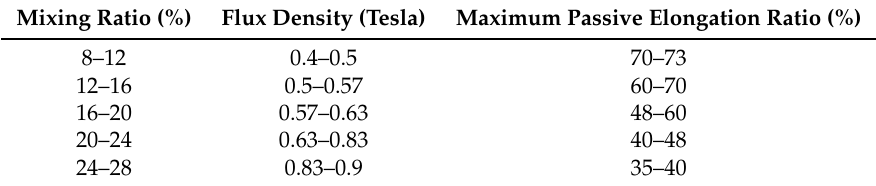
Table 2. Flux density and maximum passive elongation ratio of flexible PDMS-based permanent magnet with different magnetic particles ratio.